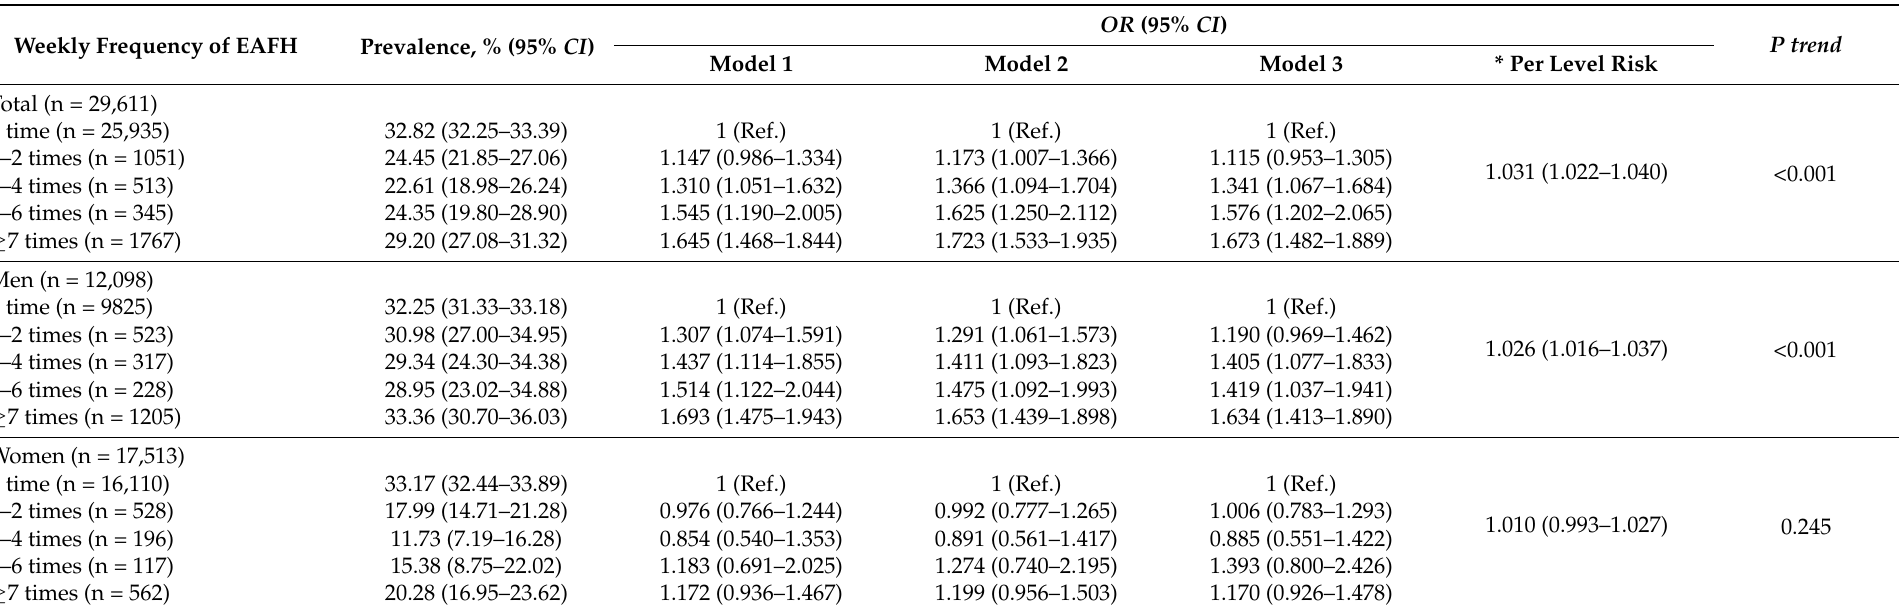
Table 2. Multivariate-adjusted OR s and 95% CI s for hypertension according to the weekly frequency of